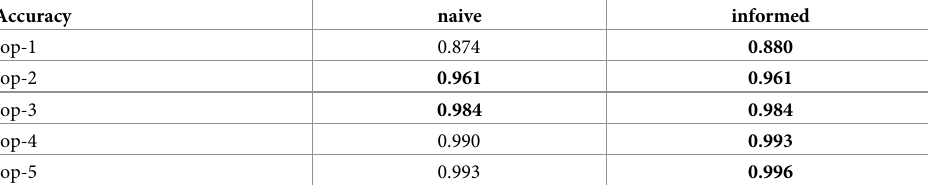
Table 6. Accuracy for the fashion-mnist data set. Top-1 to top-5 accuracy of our naive and of our informed CASIMAC on the fashion-mnist data set. In the naive approach we use a purely Euclidean distance metric between the images, whereas the informed approach also takes the structrual image similarity into account. The best scores are highlighted in